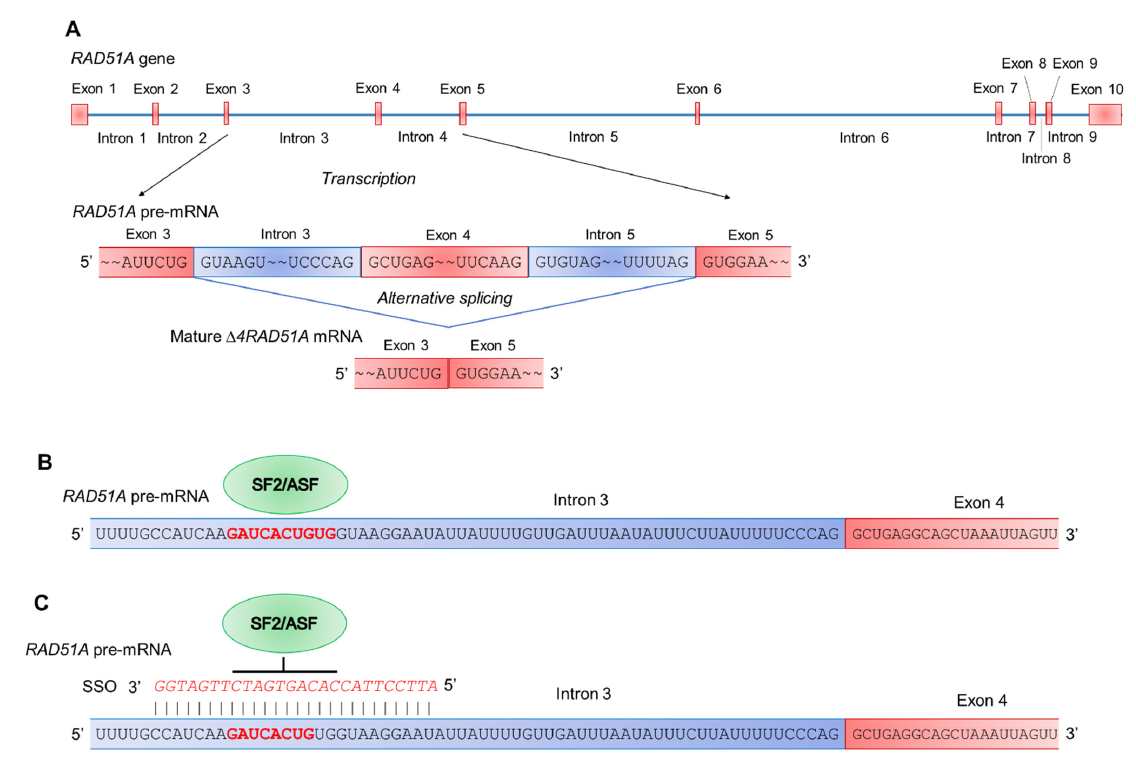
Figure 6. Schematic presentation of RAD51A alternative splicing. ( A ) Deletion of exon 4 as a result of alternative splicing and maturation of ∆ 4RAD51A mRNA. ( B ) Splicing regulator proteins SF2/ASF (shown as a green ellipse) interact with its binding sites (shown in bold red font) within intron 3 of RAD51A pre-mRNA. ( C ) Cell transfection with the 26-mer-specific antisense SSO for RAD51A (presented in red italic font) blocks the SF2/ASF proteins from binding to their binding sites. Exons are shown as red boxes, and introns are shown as blue boxes.